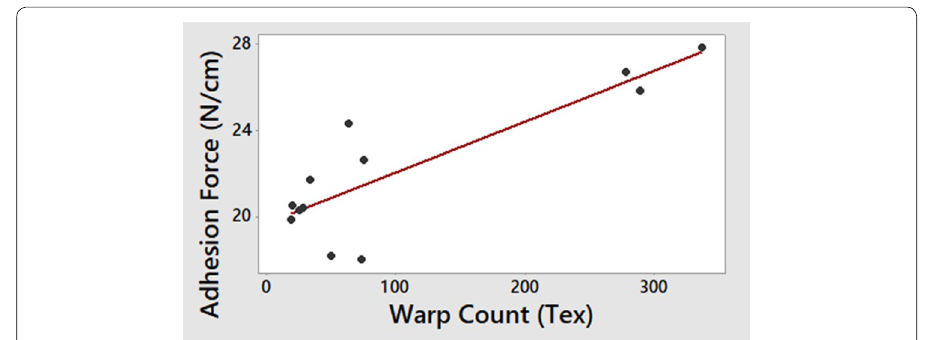
Fig. 7 Effect of warp count on adhesion force